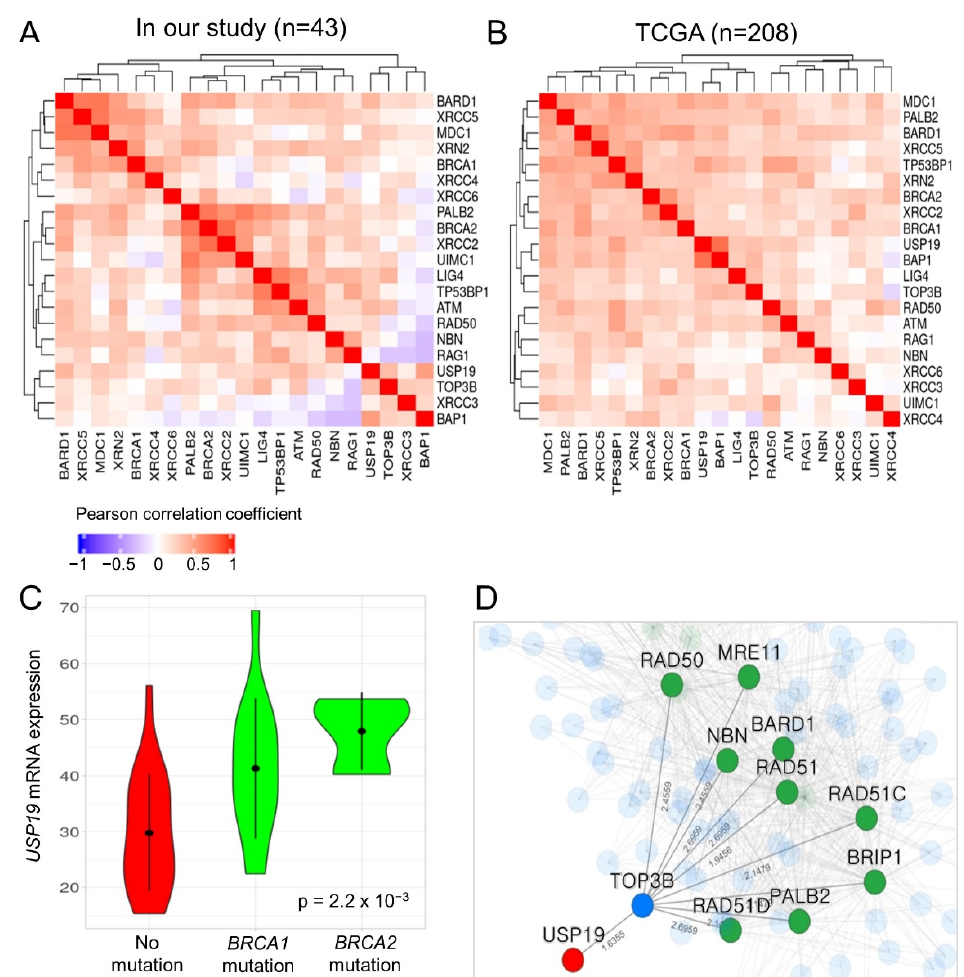
Figure 3. Functional association between USP19 and DNA double-strand (DSB) repair genes such as BRCA1/2 . ( A , B ) Co-expression pattern among USP19 , 18 DSB repair genes, and two candidate genes in our patients with HGSC and TCGA datasets, respectively. ( C ) Violin plot depicting USP19 expression according to the BRCA1/2 mutation in our patients. ( D ) Sub-network of functional associations among USP19 and hereditary pathogenic genes responsible for causing breast and ovarian cancer syndrome. Node color represents the characteristics of genes; red: USP19 , green: DSB repair genes, blue: gene connecting USP19 to DSB repair genes.